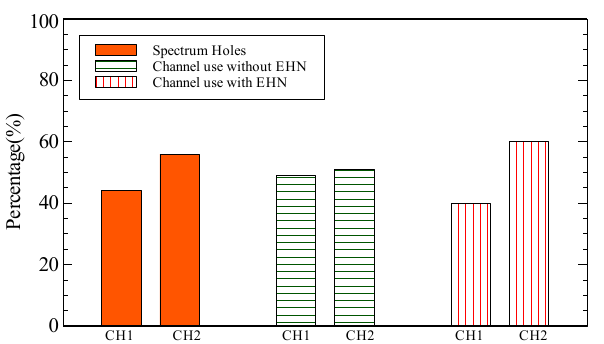
Figure 6. Secondary channel access with clear differentiation between channels